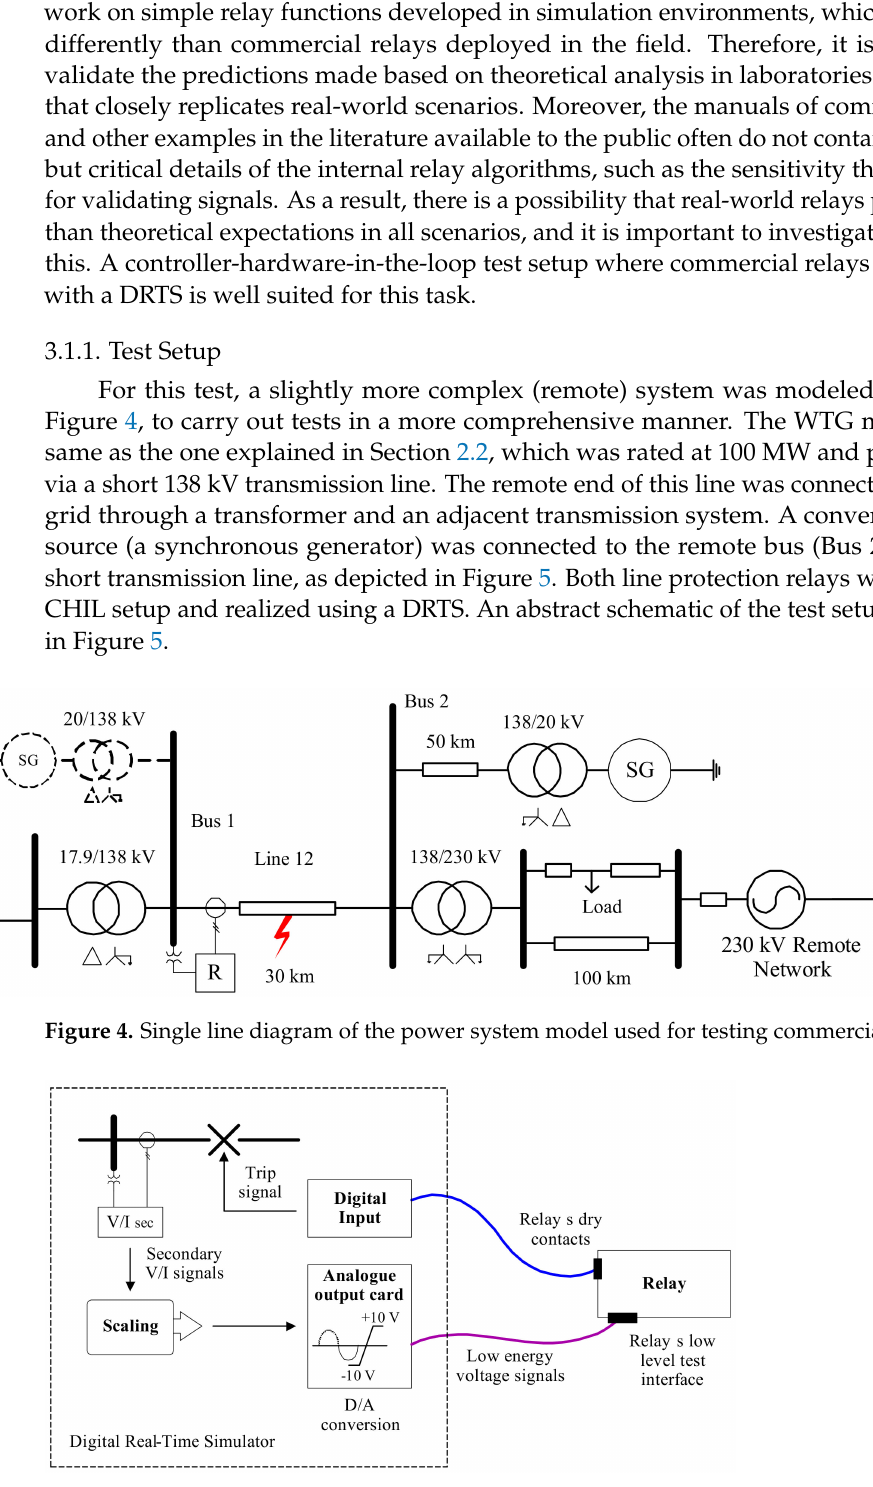
Figure 5. Schematic of the test